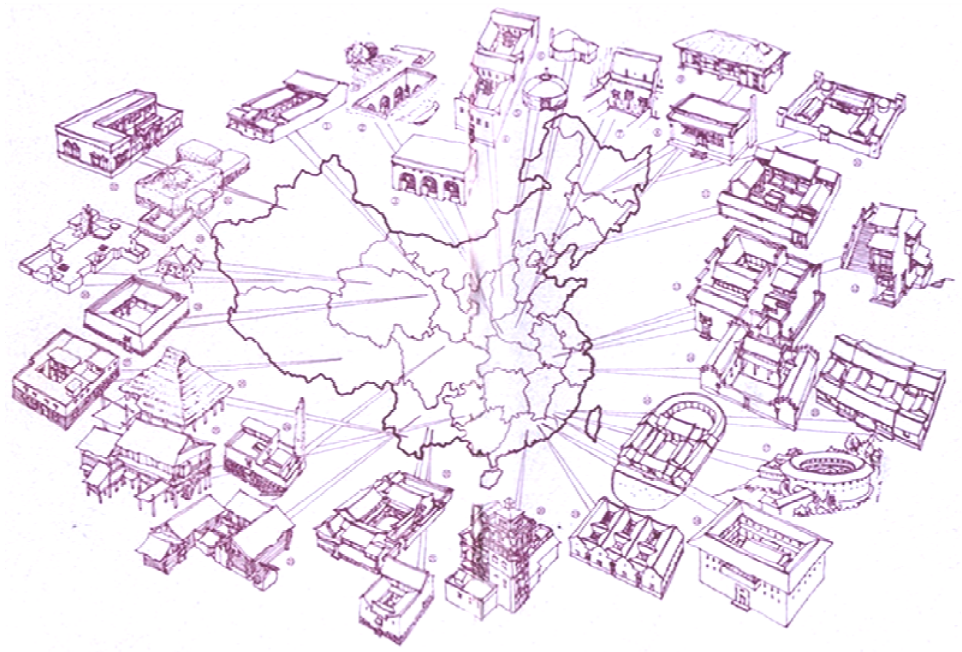
Figure 3. Vernacular architecture map [5].